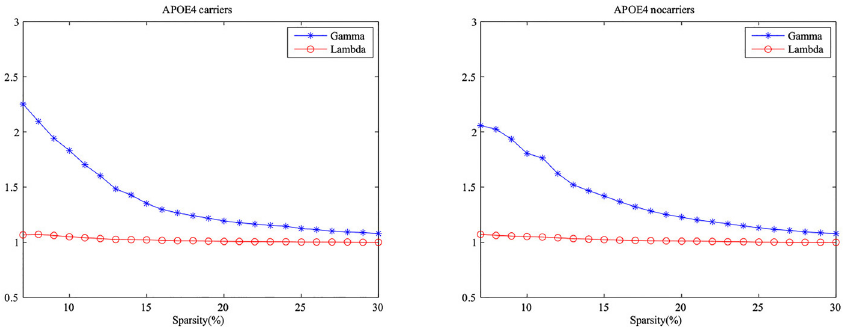
Fig 4. Small-world properties of the metabolic networks. Above graphs indicate the changes in the Gamma g ¼ C real p = C random p and Lambda l ¼ L real p = L random p in APOE ε 4 carriers and APOE ε 4 noncarriers (sparsity ranging from 7% to 26%).